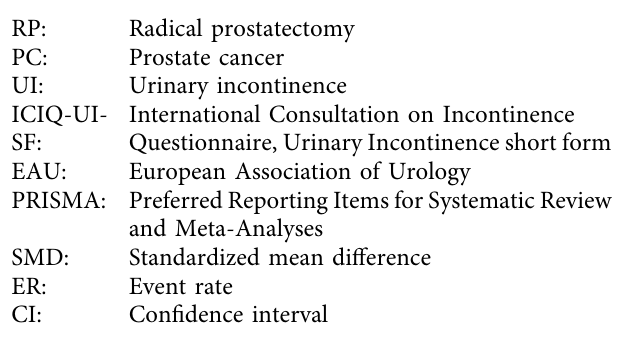
Supplementary Figure 1. Flow chart for meta-analysis (PRISMA). Supplementary Figure 2. Deeks’ funnel plots for